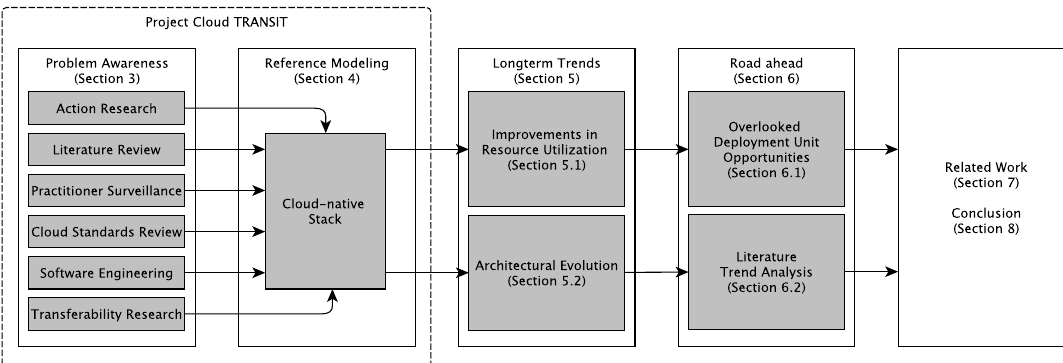
Figure 1. Research